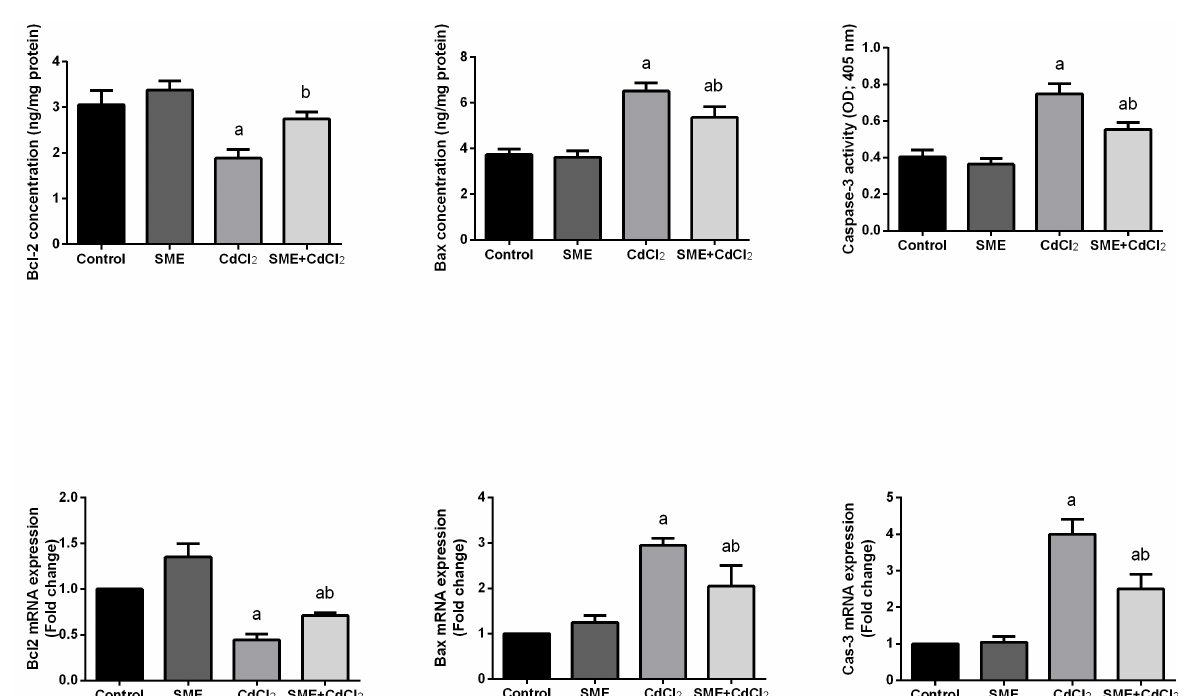
Figure 5. Pro-inflammatory cytokine production (TNF-α and IL-1β) and iNOS mRNA expression in the renal homogenate of adult male (3.5 rats treated with CdCl 2 mg/kg) and/or SME (100 mg/ kg). Values are presented as mean ± SD (n = 10). a p < 0.05 compared to the control group; b p < 0.05 compared to the CdCl -alone treatment 2 group. iNOS mRNA expression is presented as mean ± SD of two assays relative to GAPDH in the control group.